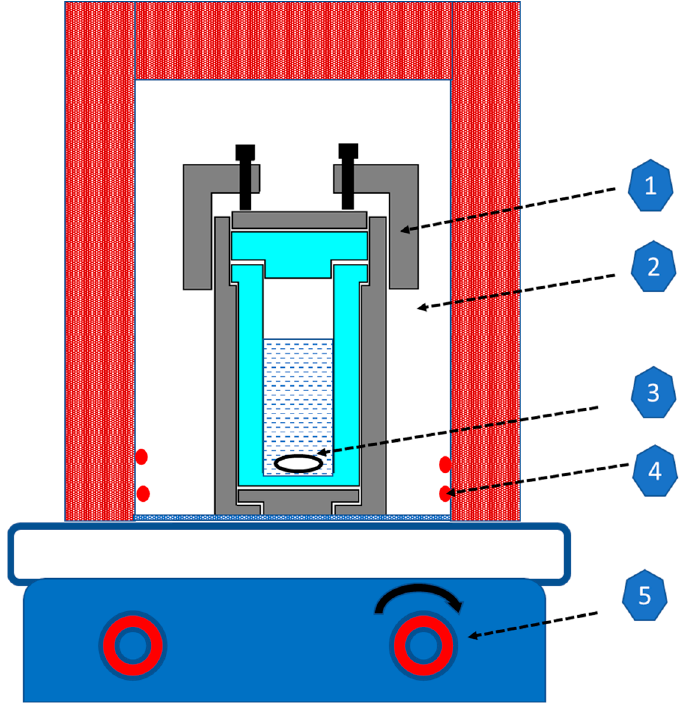
Figure 1. Hydrothermal reactor setup: (1) autoclave; (2) oven; (3) magnet; (4) heating coil; and (5) magnetic stirrer.